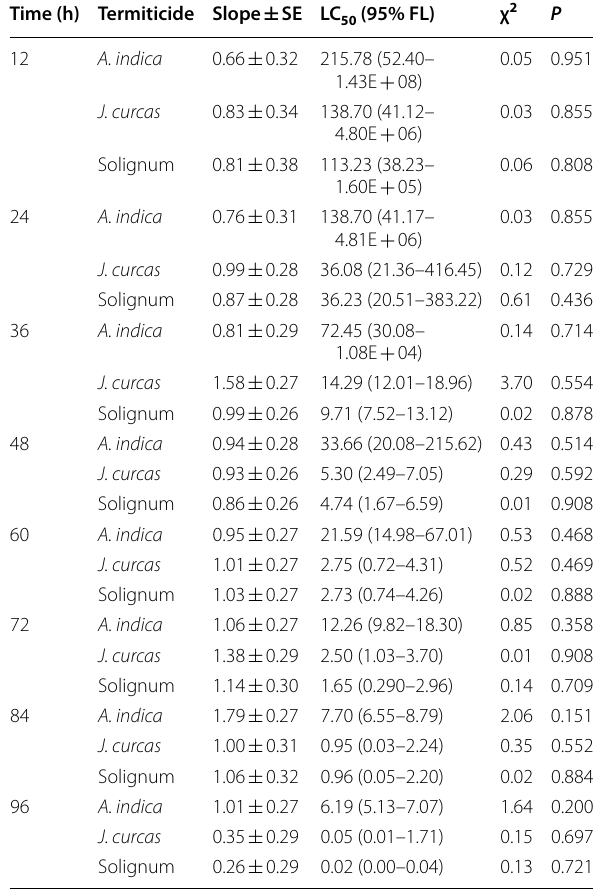
N 50 termites; SE, standard error; LC: Lethal concentration (mLkg − 1 ); FL, = Fiducial limits; χ 2 , Chi -square value, P , Probability value; h, hours